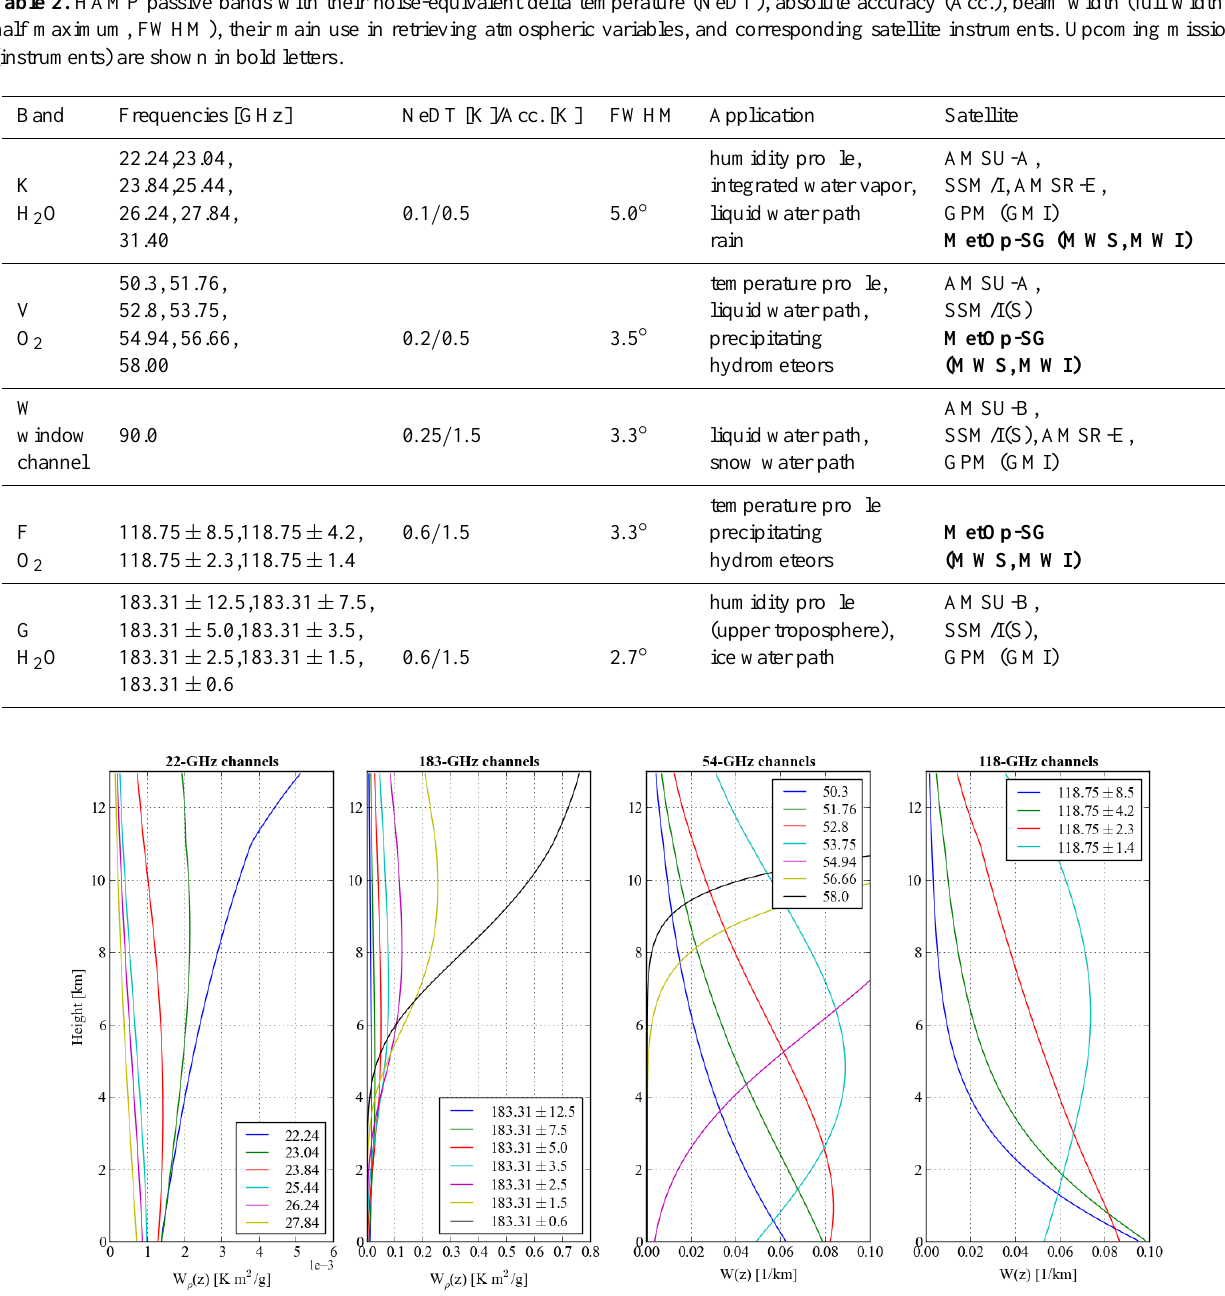
Figure 3. HAMP clear air weighting functions (nadir downward looking). Shown are the water vapor (two leftmost) and the temperature (two rightmost) weighting functions for a HALO ceiling height of about 13km. The US 1976 Standard Atmosphere over a black surface was assumed for the